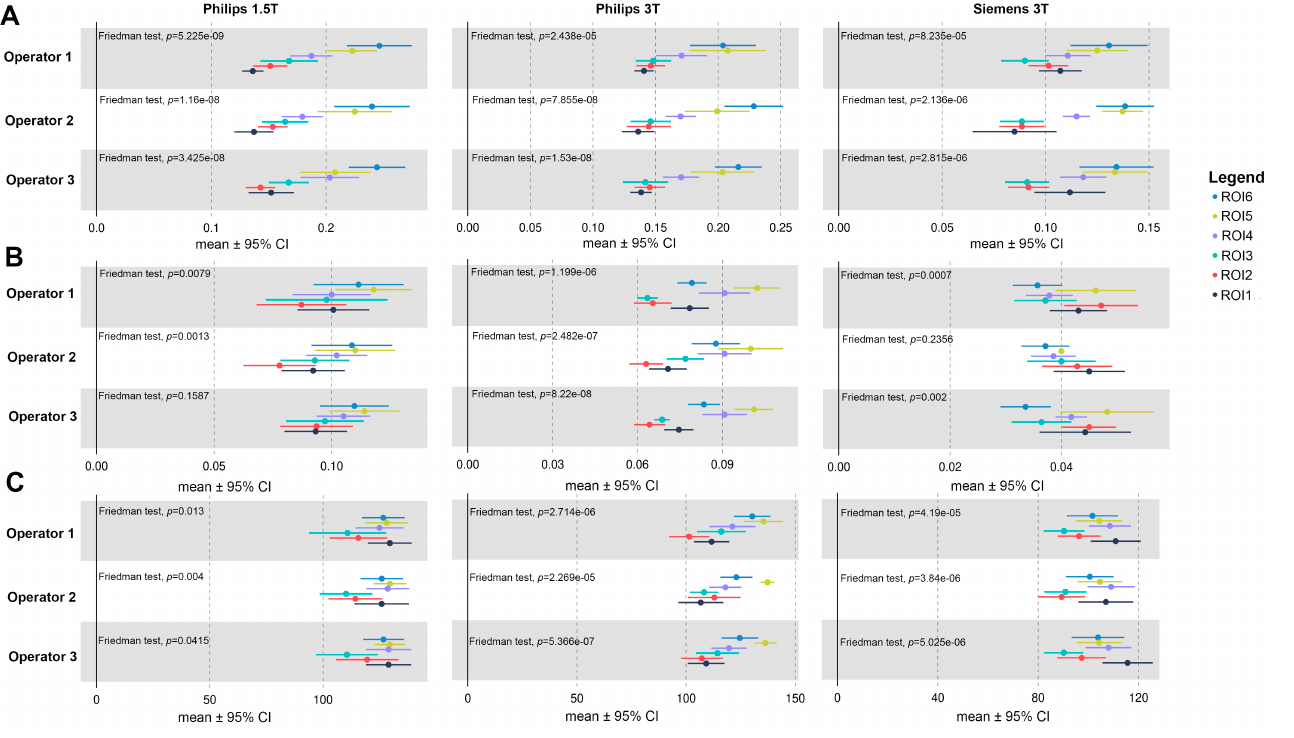
Figure 3. Forest plot of the mean with 95% CI obtained from each ROI and from the three devices (Philips 1.5 T, Philips 3 T and Siemens 3 T) for the ( A ) AxialWSS, ( B ) CircWSS, ( C ) Flow parameters. Horizontal lines through the circle represent 95% confidence intervals. The circle represents the mean.